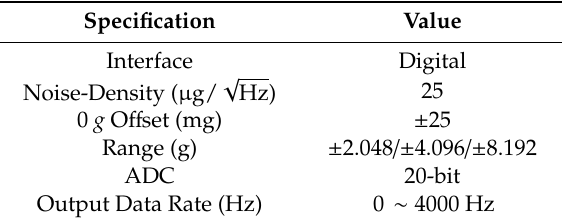
Table 2. The specifications of the ADXL355 MEMS accelerometer.